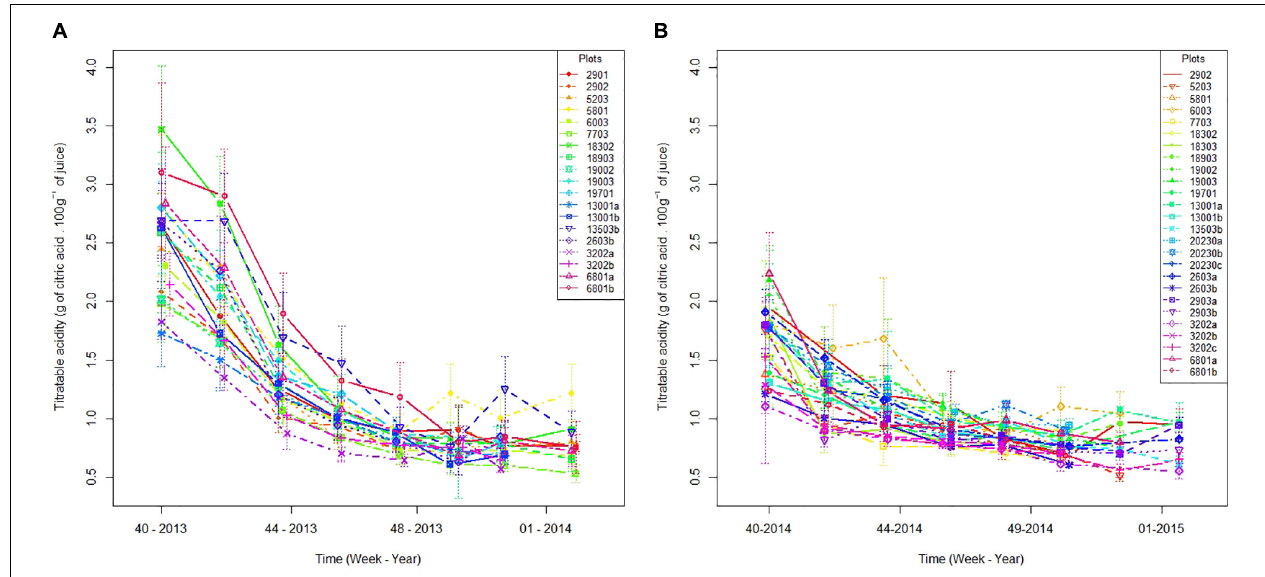
FIGURE 1 | Plot acidity evolution in 2013 (A) and 2014 (B) between the week 40 and the end of harvests. Vertical lines represent standard